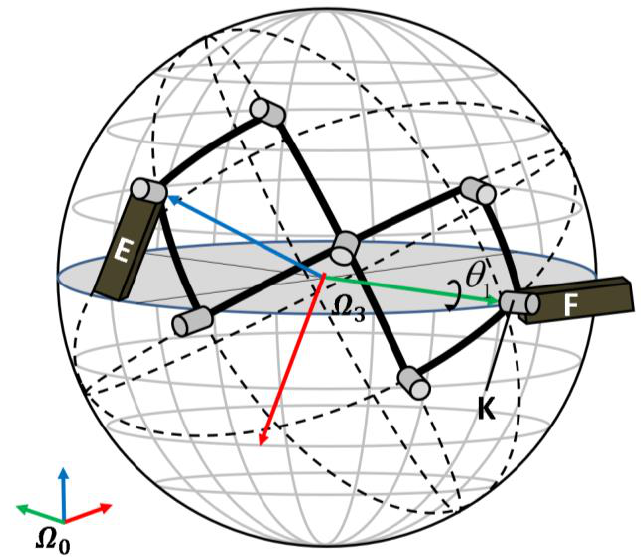
Figure 8. Frame rotation with the shoulder abduction/adduction motion. When the wearer performs shoulder medial/lateral motion and moves θ 2 , the frame will rotate around the X axis of itself, as illustrated in Figure 9.